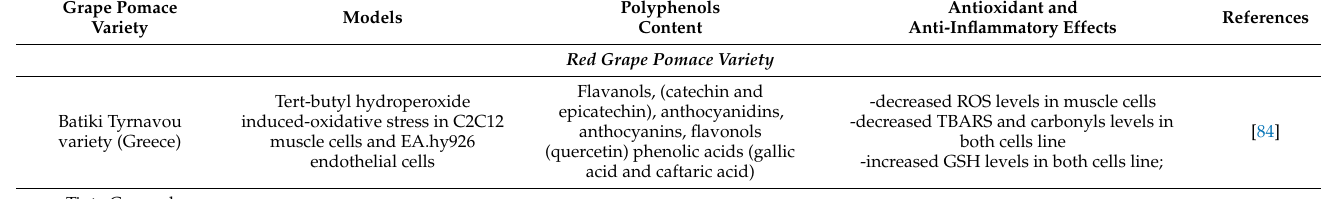
Table 1. In vitro beneficial actions of grape pomace in oxidative stress and